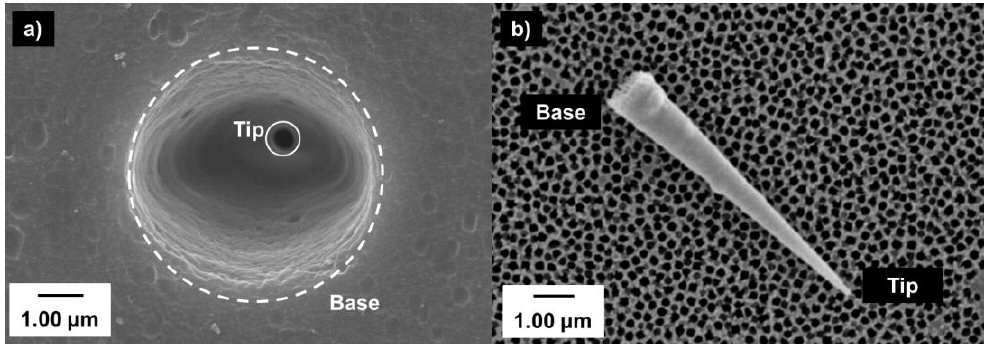
Figure 2. SEM of ( a ) base opening in a track-etched conical-pore polycarbonate membrane; ( b ) a gold replica of a conical polyethylene terephthalate pore.